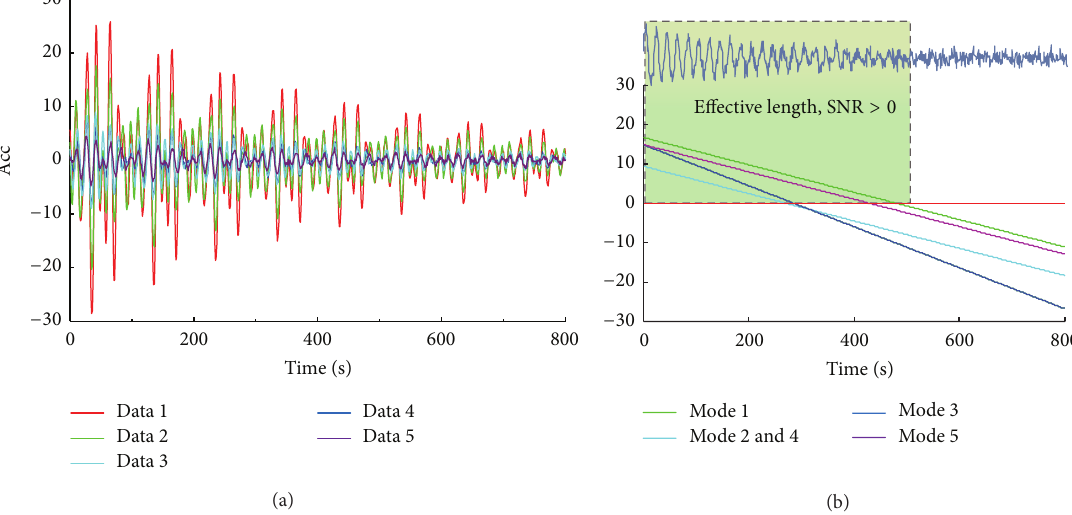
Figure 2: Free response history of a 5-DOF oscillation system: (a) data history; (b) effective length of each mode’s contribution to the 1st DOF